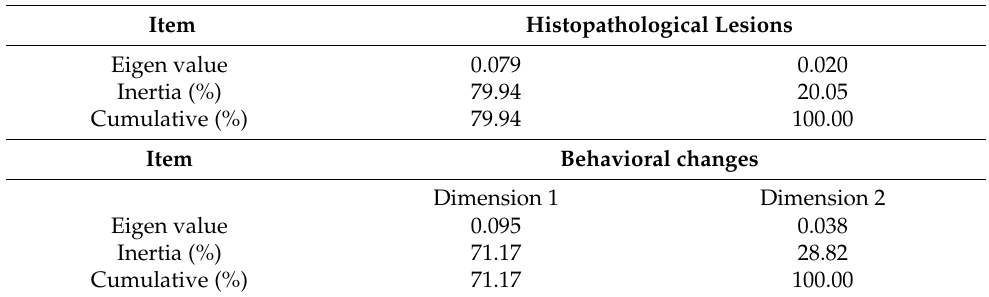
Table 5. Dimension inertia of correspondence analysis of histopathological lesions and behavioral changes observed in rainbow trout fingerlings infected with several Aeromonas